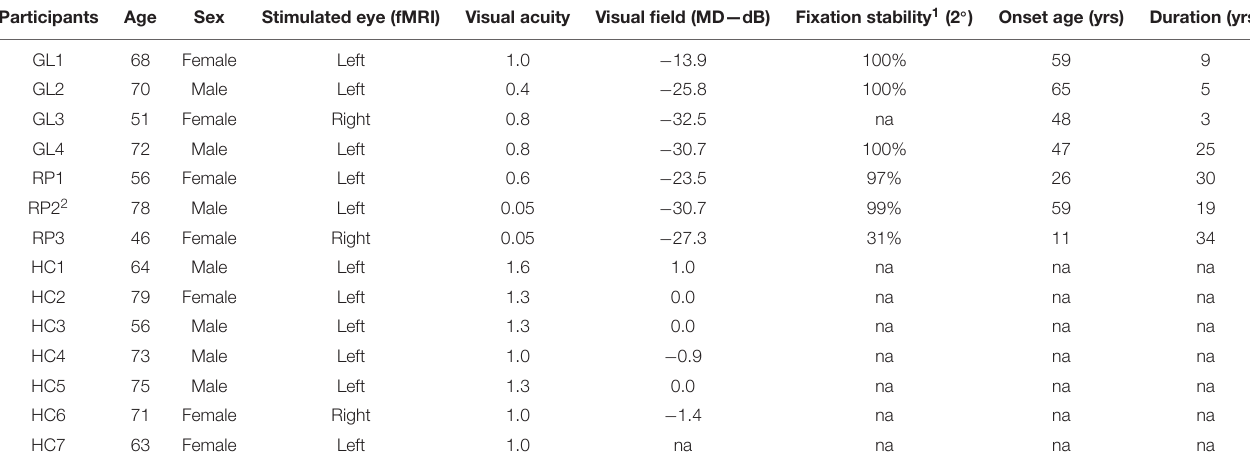
TABLE 1 | Participant demographics and clinical